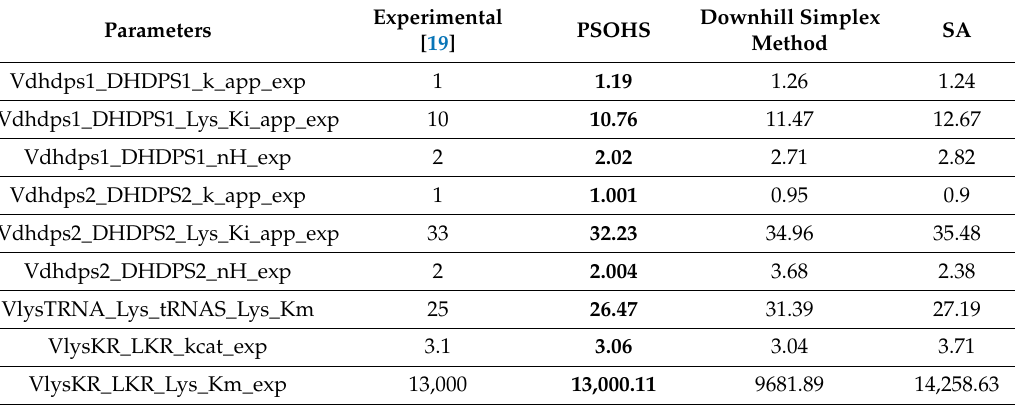
Table 6. List of kinetic parameter values for lysine with the experimental